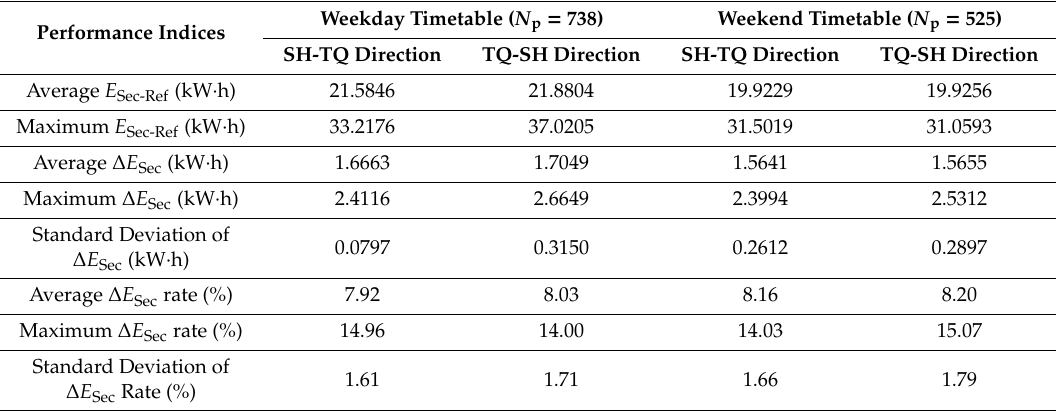
Table 3. Performance of the BFO-based energy e ffi cient profiles over the reference solutions.